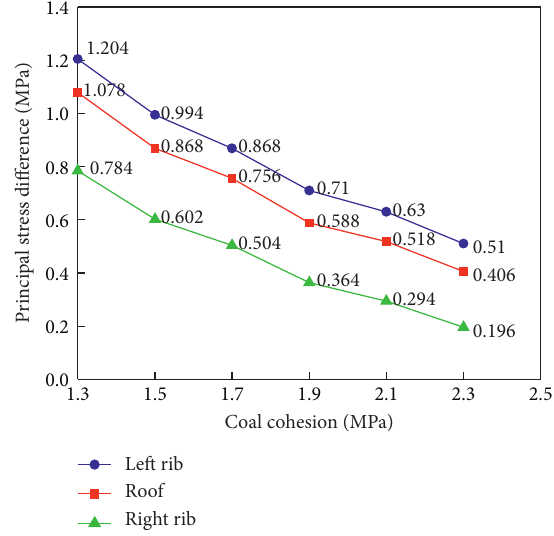
Figure 7: Principal stress difference at different coal cohesion